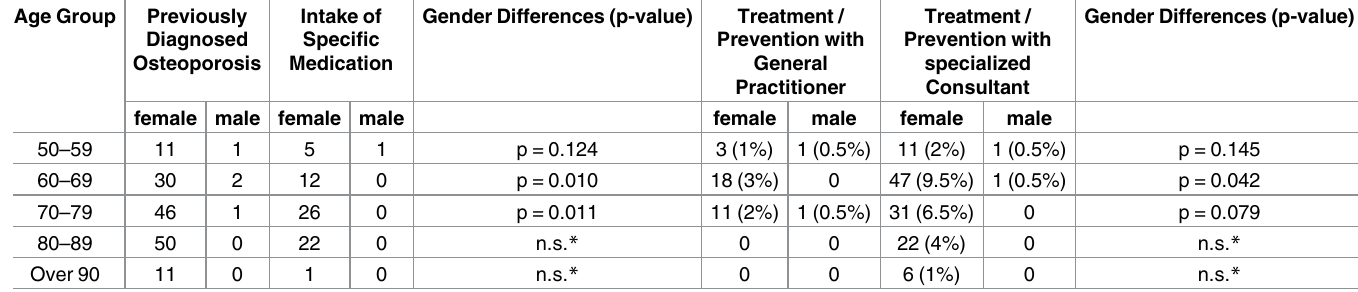
Table 4. Prevention. Previoustreatment of osteoporosis and primary prevention as well as Secondary preventionof osteoporoticfractures and its associ- ated fractures. Age Group Previously Diagnosed